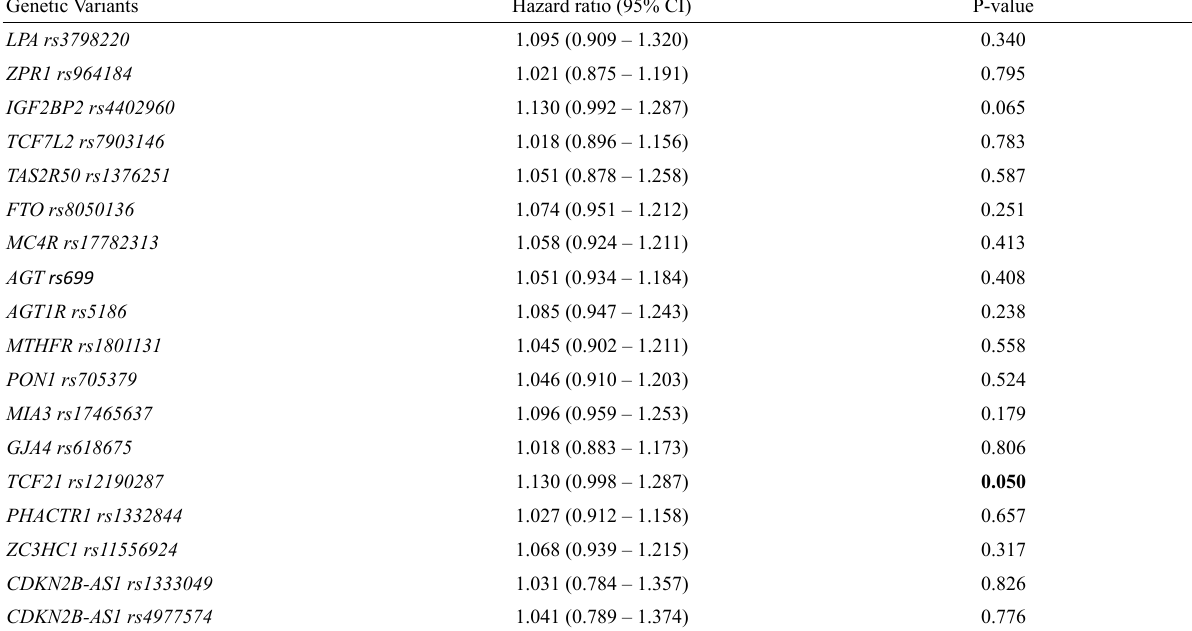
Table 2 ‒ Genetic variants associated with MACE occurrence.